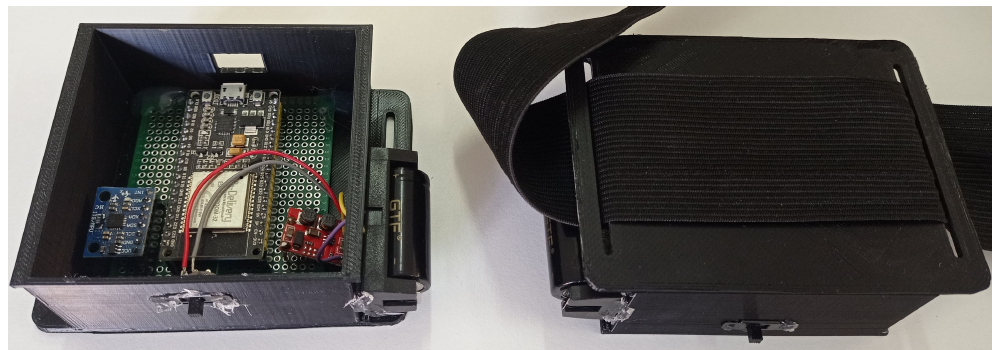
Figure 2. The electronic components soldered inside the